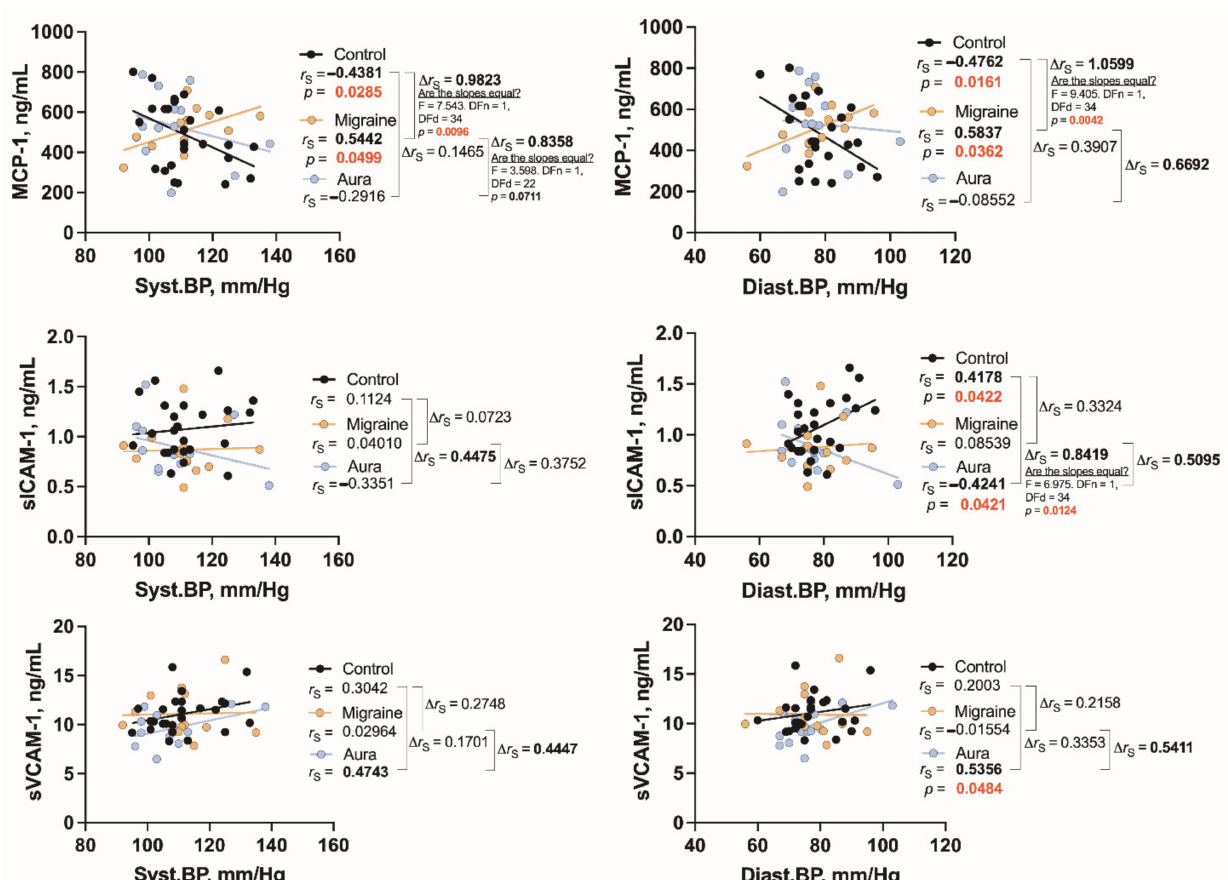
Figure 4. The relationship between BP (Syst.: systolic, Diast.: diastolic) and MCP-1, sICAM-1, and sVCAM-1 in healthy individuals (control) and in patients with migraine without aura (migraine) and with aura (aura). r S : Spearman’s rank correlation coefficient, ∆ r S : the difference between the correlation coefficients as an indicator of the magnitude of the differences (more pronounced or significant differences are marked in